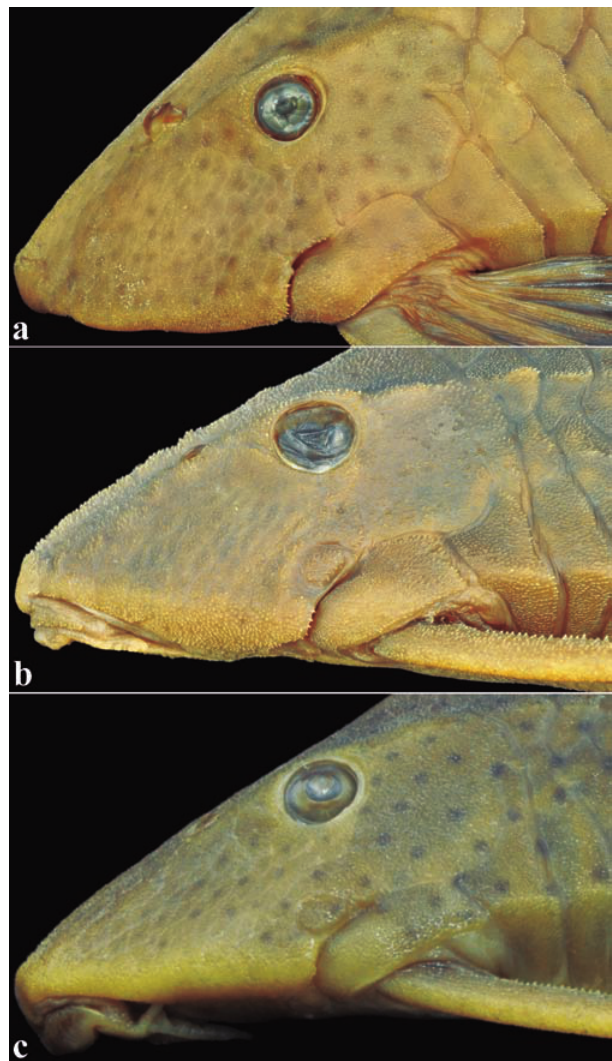
Fig. 3. Opercle morphology of (a) Hypostomus cochliodon , NUP 10809, 215.8 mm SL, showing indistinct opercle without odontodes; (b) Hypostomus basilisko , holotype, MZUSP 111110, 182.5 mm SL and (c) Hypostomus khimaera , holo- type, MZUSP 111129, 139.1 mm SL, showing layer of skin surrounding opercle that supports